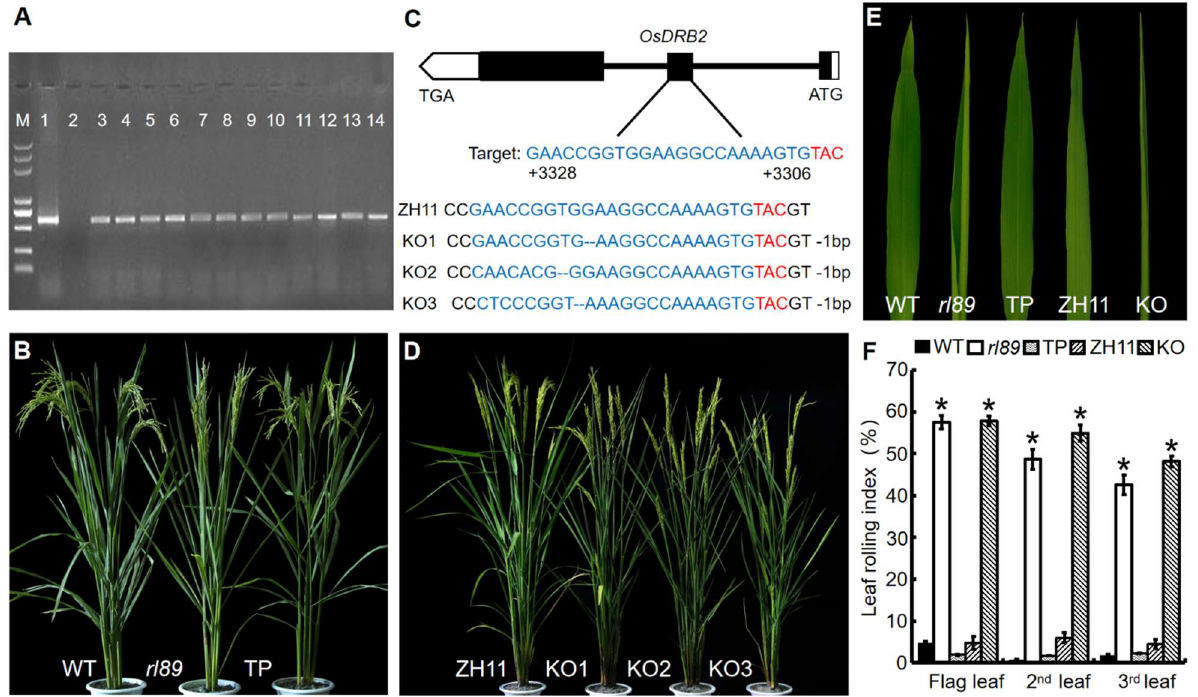
Figure 4. Complementation of the rl89 mutant and knockout of the OsDRB2 gene. ( A ) Identification of transgenic lines by PCR. M, DL-2000 plus Marker; 1, pCAMBIA1300- OsDRB2 plasmid (PCR pos- itive control); 2, rl89 (PCR negative control); 3-14, positive transgenic plants (TP). ( B ) Phenotypes of the wild type (WT), rl89, and TP during the grain filling stage. ( C ) Schematic diagram of the target site in the OsDRB2 . The 5’-UTR, 3’-UTR, exons, and introns are indicated by white rectangles, white pentagons, black rectangles, and black lines, respectively. The targeted site is labeled in blue upper- case letters, and the protospacer adjacent motif (PAM) sequences are highlighted in red. Sequence alignment of the OsDRB2 target site was performed between the knockout mutants (KO, including KO1, KO2, and KO3) and the control variety Zhonghua 11 (ZH11) background. The deleted se- quences are shown by blue hyphens, and the number of the deleted nucleotides is showed on the right. ( D ) Phenotypes of ZH11 and the knockout mutants during the grain filling stage. ( E ) Flag leaf phenotypes of WT, rl89 , TP, ZH11, and KO at the heading stage. ( F ) LRIs of the top three leaves (the flag, 2nd and 3rd leaves from the top of main stem of a single plant) from WT, rl89, TP, ZH11, and KO at the heading stage. A error bar represents the SD of three independent experiments. Asterisks indicate statistically significant differences among WT, rl89, and TP, or between ZH11 and KO at p < 0.05. 2.4. Subcellular Localization of OsDRB2 Protein It was reported that Arabidopsis DRB2 was located in the cytoplasm and in the nu- cleus [31]. To confirm the localization of OsDRB2 in rice, we constructed the vector ex- pressing the OsDRB2-GFP fusion protein. Then, the resulting pC2300-35S- OsDRB2 -eGFP vector and the empty eGFP vector (a control) were co-transformed with the WRKY45- RFP vector (as a marker for nuclear) into tobacco cells, respectively. The result showed that green fluorescence from OsDRB2-GFP fusion protein was not only overlapped with red fluorescence from WRKY45, but also presented in cytoplasm (Figure 5A). As a control, the green fluorescence of eGFP was observed throughout the cell, including nucleus and cy- toplasm (Figure 5B). This result suggested that OsDRB2 is indeed located in both nucleus and cytoplasm.